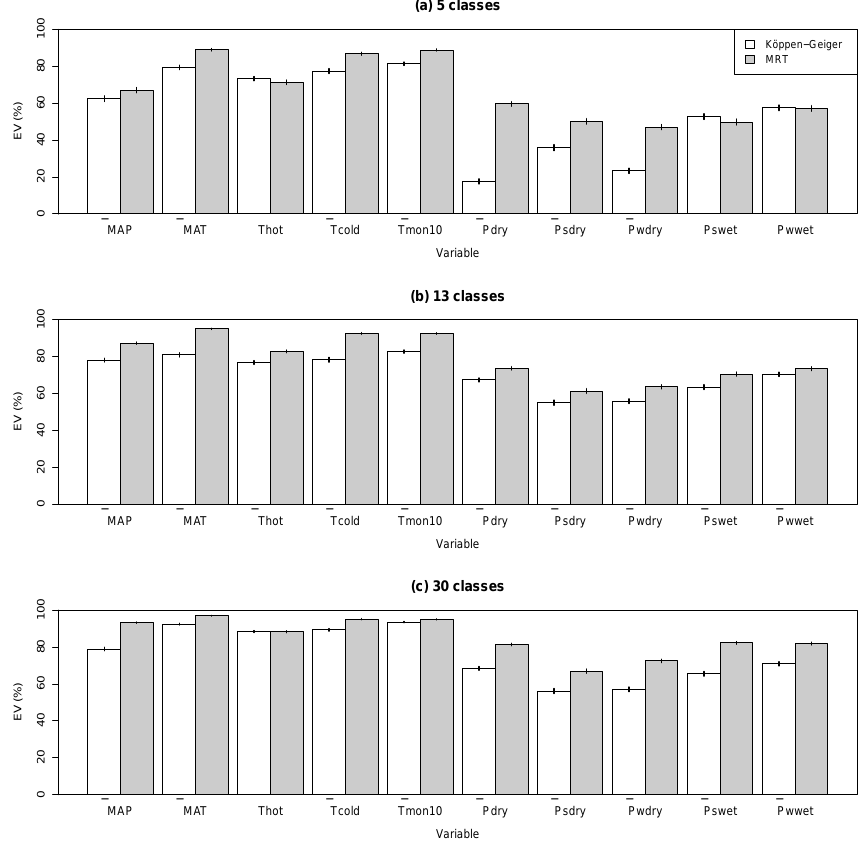
Fig. 8. As in Fig. 7, but for climate variables defined in Table